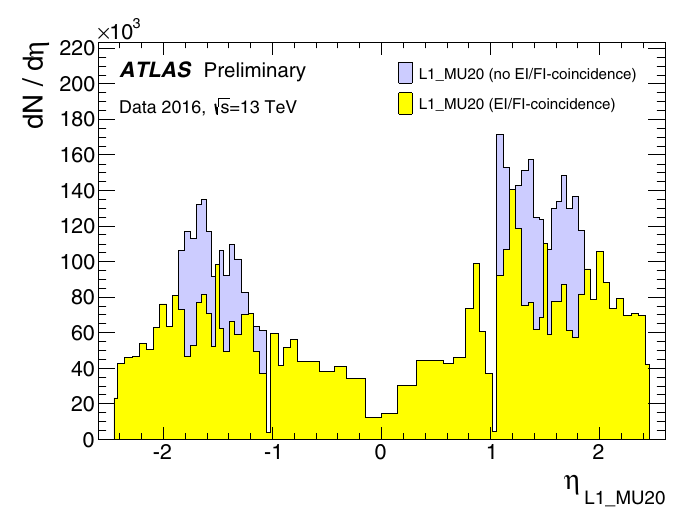
Figure 1. Schematic drawing of one quarter cross-section of the muon system of the ATLAS detec- tor [2]. Figure 2. The pseudorapidity ( η ) distributions of the Level 1 muon trigger with a muon p T threshold of 20 GeV (L1_MU20) with and without the additional coincidence based on the small-wheel TGCs in the FI and the EI chambers